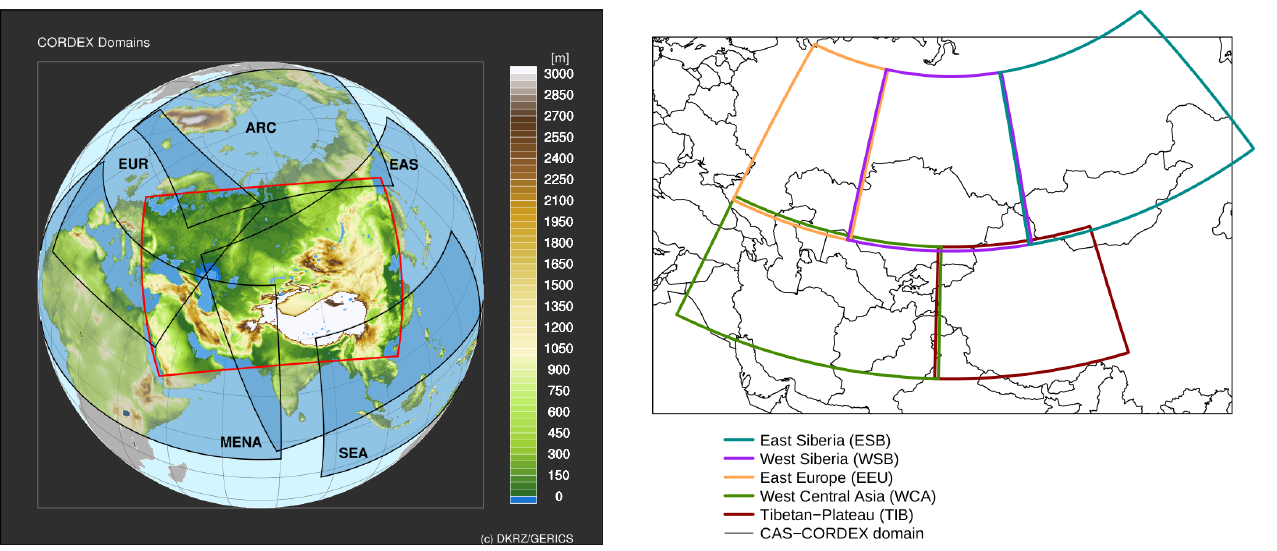
Figure 1. The CAS-CORDEX domain delineated by a red con- tour and the main overlapping CORDEX domains (black contour lines): Europe (EUR), Arctic (ARC), South-East Asia (SEA), East Asia (EAS), and MENA projected upon the topography of Eurasia (geopotential height in meters of the GTOPO30 global digital ele- vation model – DEM – 3). All points with orography higher than 3000m are colored white.